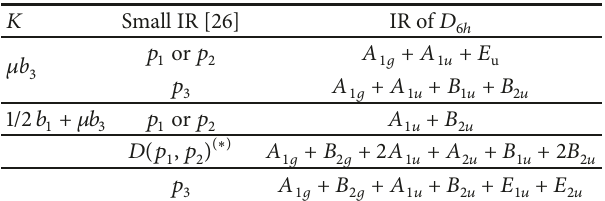
Table 6: Characters of representation 𝑃 − 𝐼 for Cooper pairs on symmetry planes (001) in the case of strong spin-orbit coupling (space-group 𝐷 4 6ℎ ).